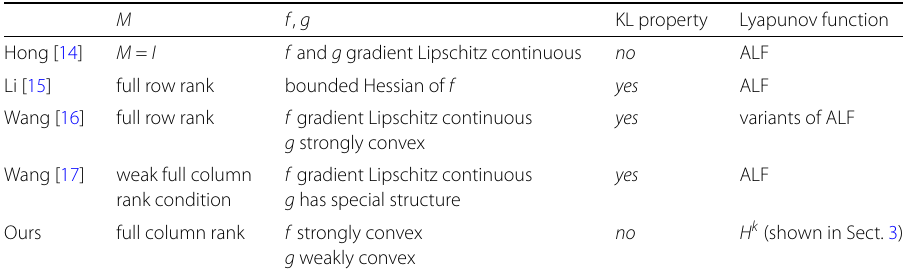
Table 1 Regularity conditions to convergence analysis of ADMM for nonconvex optimization